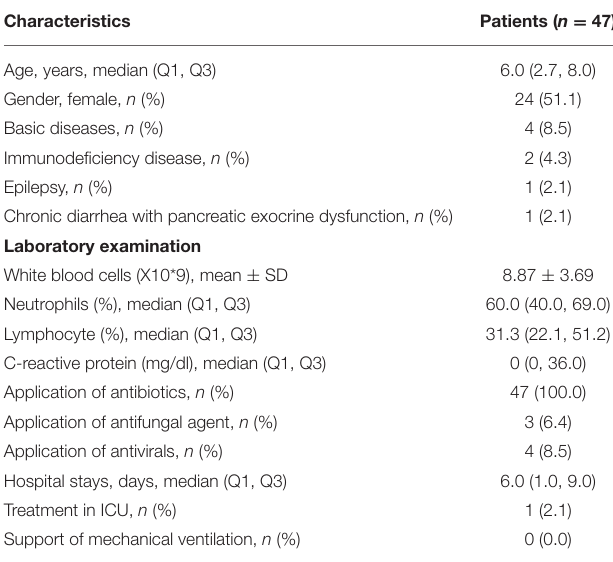
TABLE 1 | Clinical characteristics of